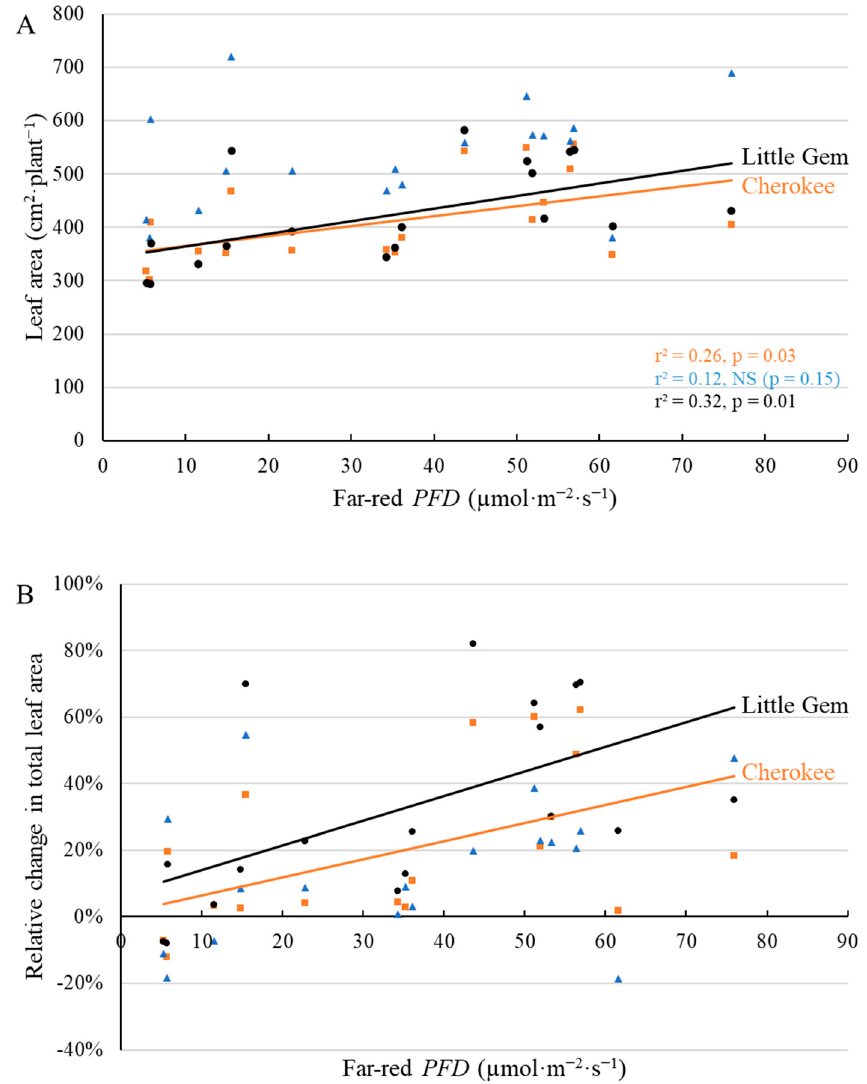
Figure 4. With a background of 204 µ mol · m − 2 · s − 1 white LED light, supplemental far-red photons linearly increased leaf area ( A ) and the relative change in leaf area (( B ), compared to plants without supplemental far-red light) at 21 days after the start of far-red light treatment for ‘Cherokee’ and ‘Little Gem’ lettuce, but not for ‘Green Saladbowl’ (blue triangles). The r 2 and p values for regression of each cultivar apply to both graphs and are shown with the respective color.